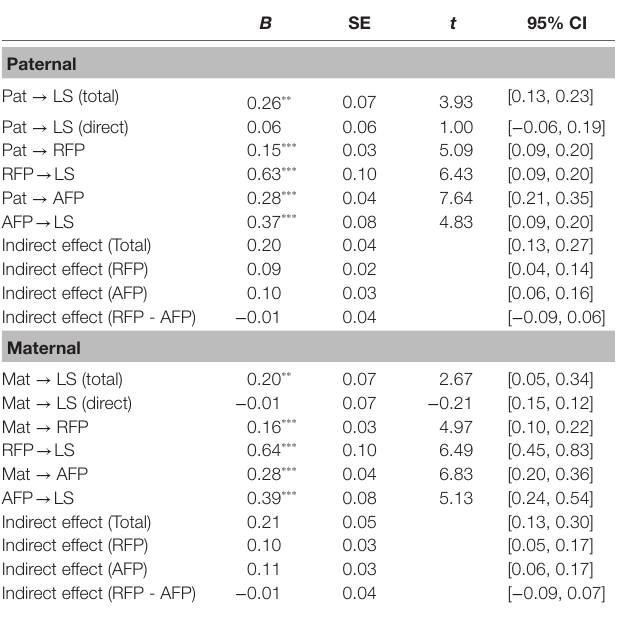
TABLE 2 | Summary of the mediation model